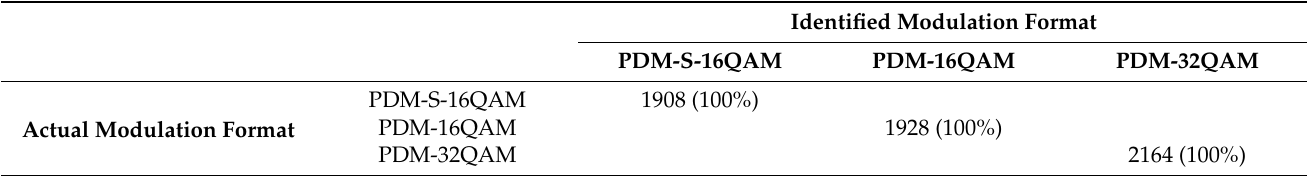
Table 2. The MFI recognition accuracy of the three modulation formats (PDM-S-16QAM, PDM-16QAM and